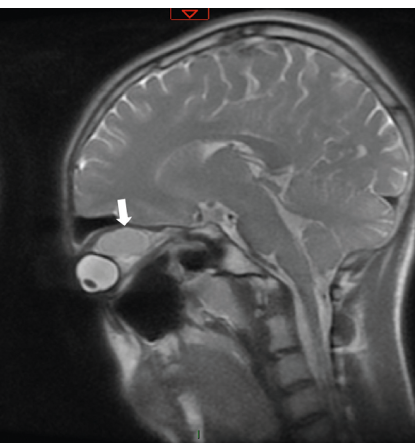
Figure 2: Sagittal T1-weighted MRI. The exact position and extent of the tumor and its relation to the optic nerve are clearly visible. There is a noticeable ocular bulb dislocation (white arrow).